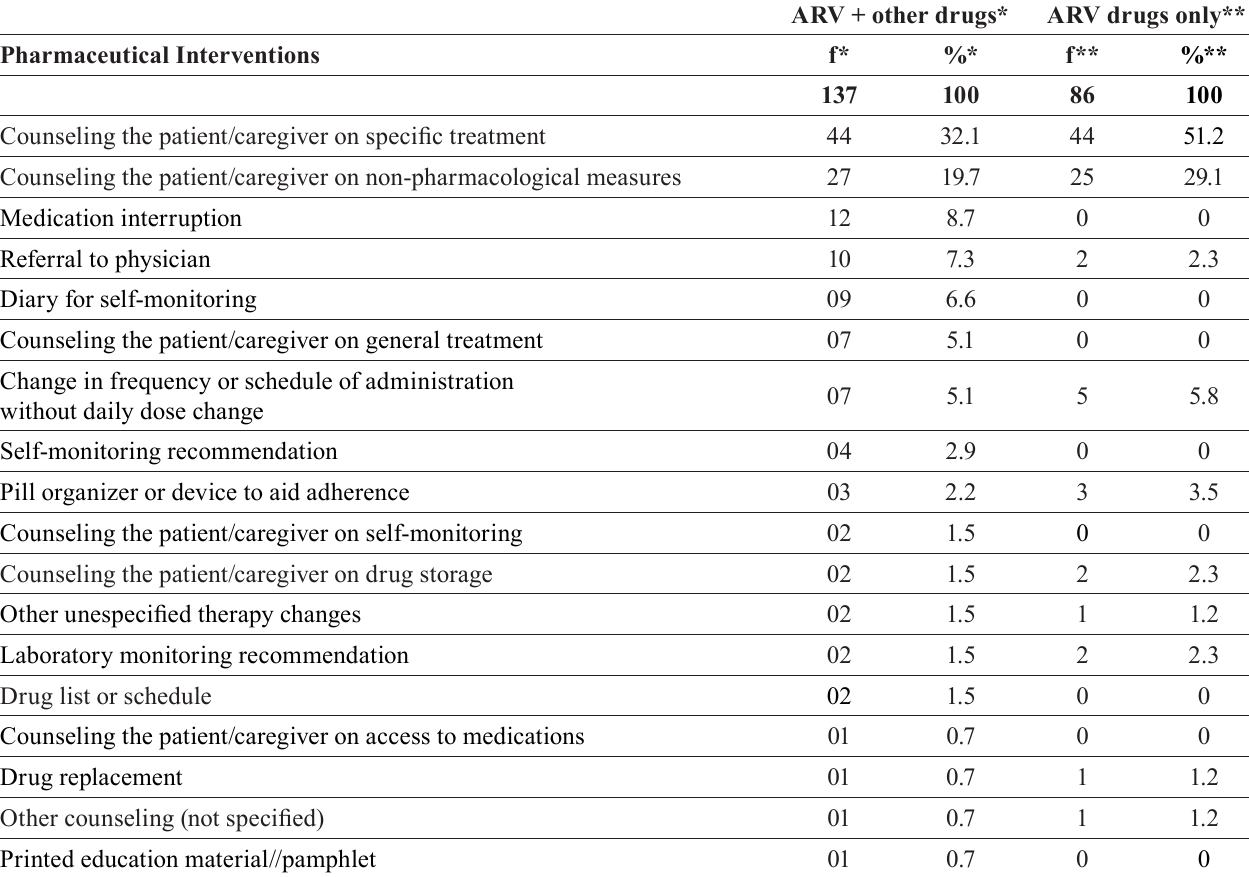
TABLE III – Pharmaceutical Interventions